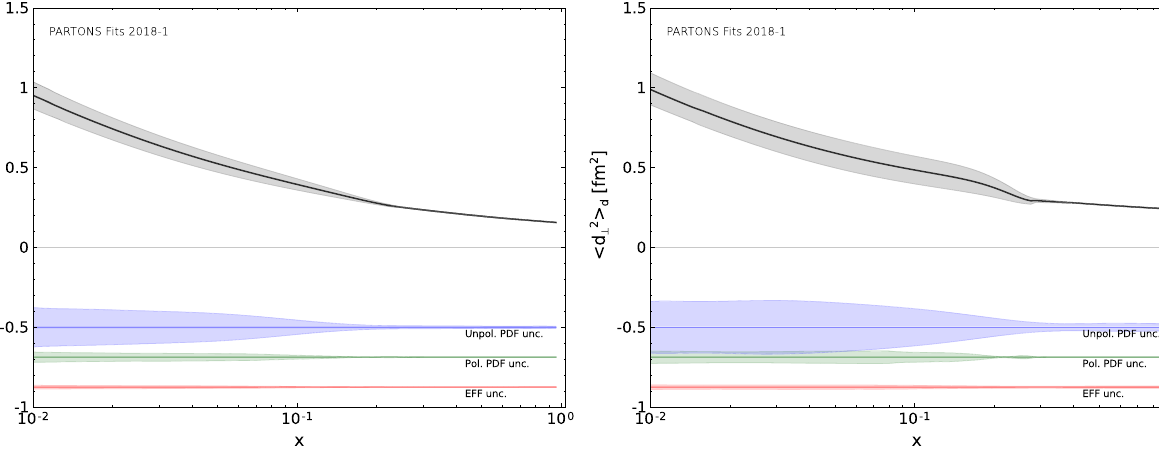
Fig. 19 Difference between (cid:5) b 2 ⊥ (cid:6) For further description see Fig.